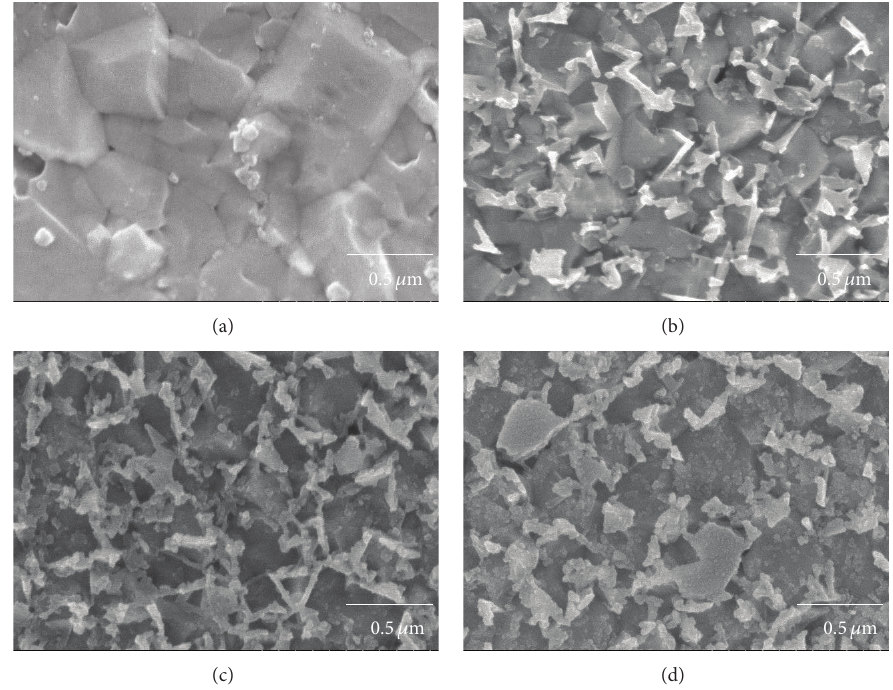
Figure 4: Microstructures of sintered hard materials: (a) WC, (b) WC-3wt% Fe, (c) WC-3wt% Ni, and (d) WC-3 wt% Co.